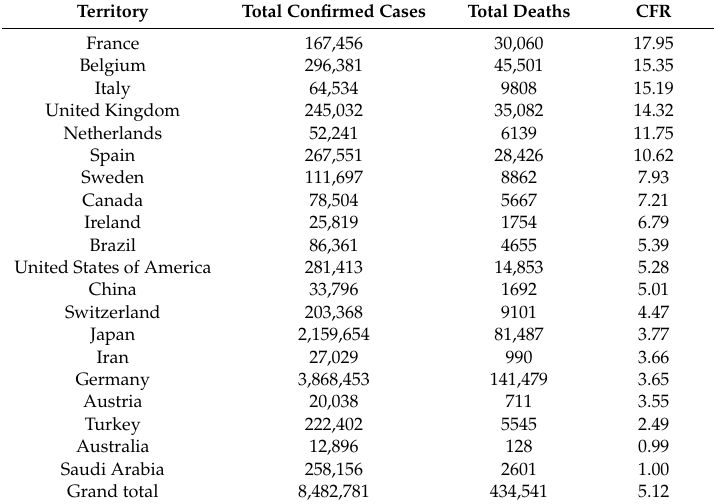
Table 1. Case fatality ratio of Coronavirus Disease 2019 (COVID-19) in major countries of the world *. CFR, case fatality